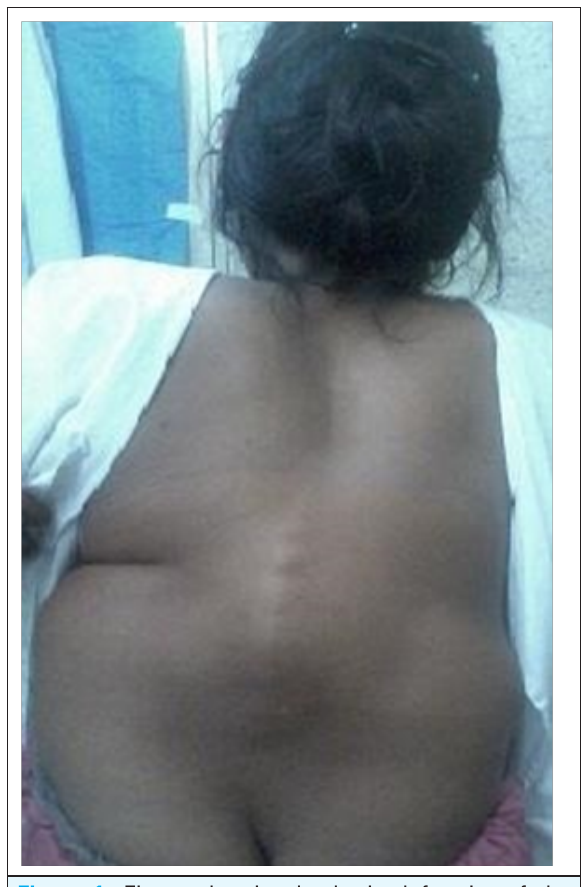
Figure 1. Figure showing kyphotic deformity of the patient.